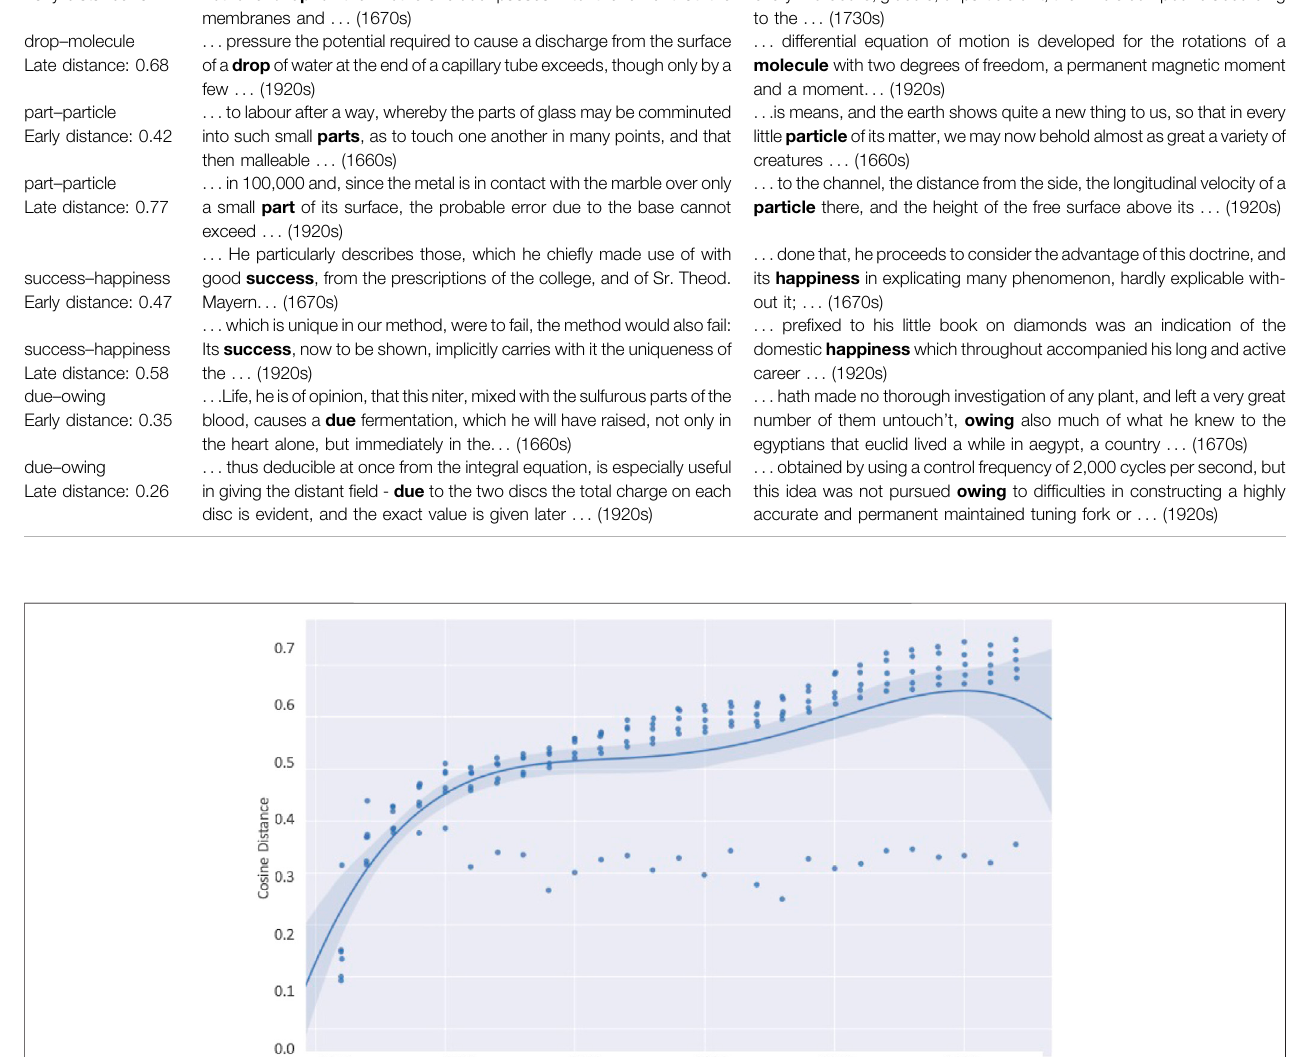
Frontiers in Communication |